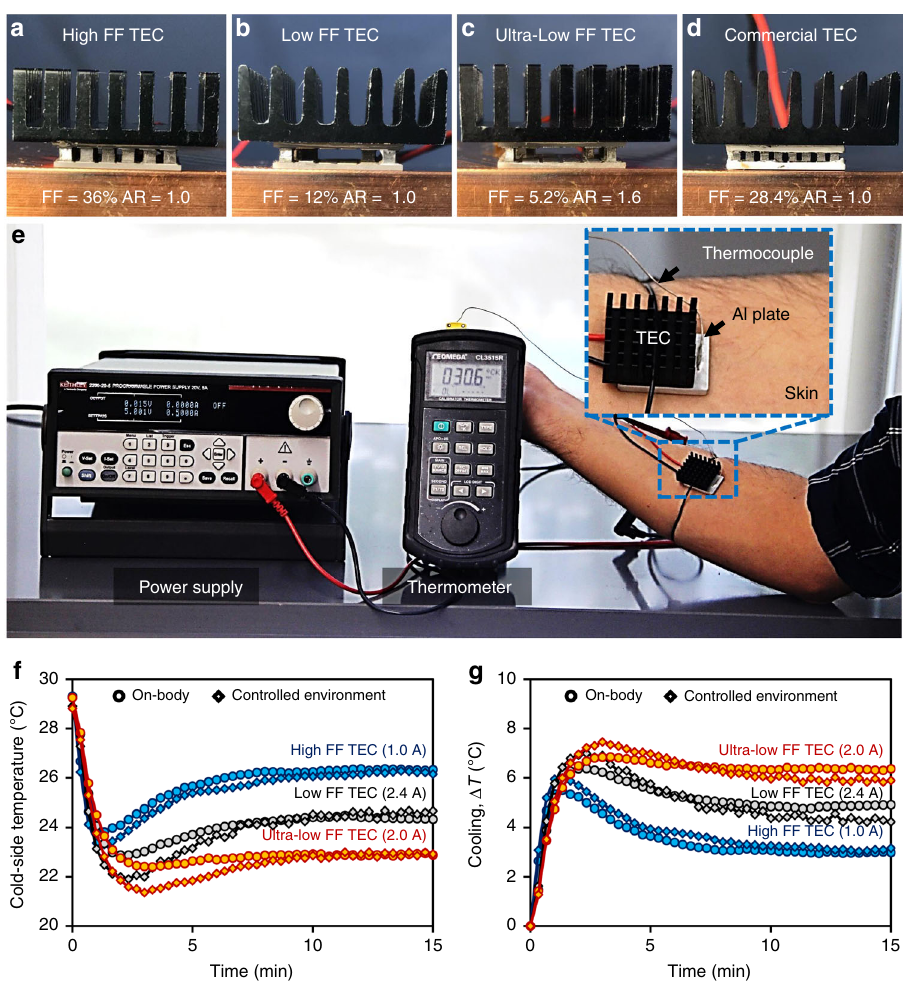
Fig. 5 TEC modules and experimental set-up. Fabricated TEC modules: a high- fi ll factor (FF = 36% and AR = 1.0), b low- fi ll factor (FF = 12% and AR = 1.0), c ultra-low fi ll factor (FF = 5.2% and AR = 1.6), and d a commercial TEC module (FF = 28.4% and AR = 1.0). e Experimental set-up used to characterize the TEC modules on human body. f , g Transient study performed on different FF TECs under controlled environment and on human body. The transient minima are lower than steady state cold-side temperature for all TECs. The ultra-low FF TEC generates least cold-side temperature and thus maximum cooling followed by low-FF TEC and high-FF